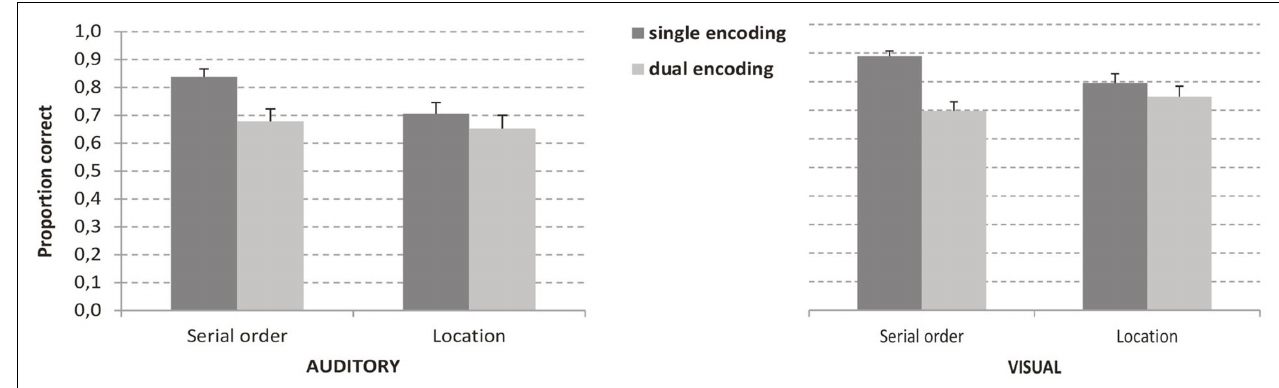
FIGURE 2 |Accuracy in the serial order and location tasks in the two modalities as a function of the encoding condition. Error bars represent